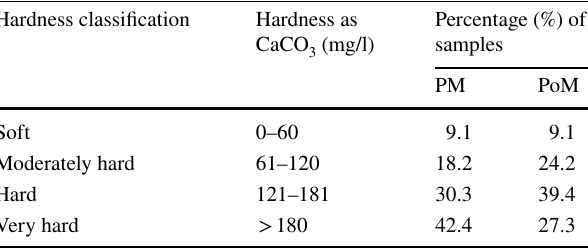
BDL Betlow detection Table 2 USGS hardness classification of groundwater samples during PM and PoM seasons for the study area Hardness